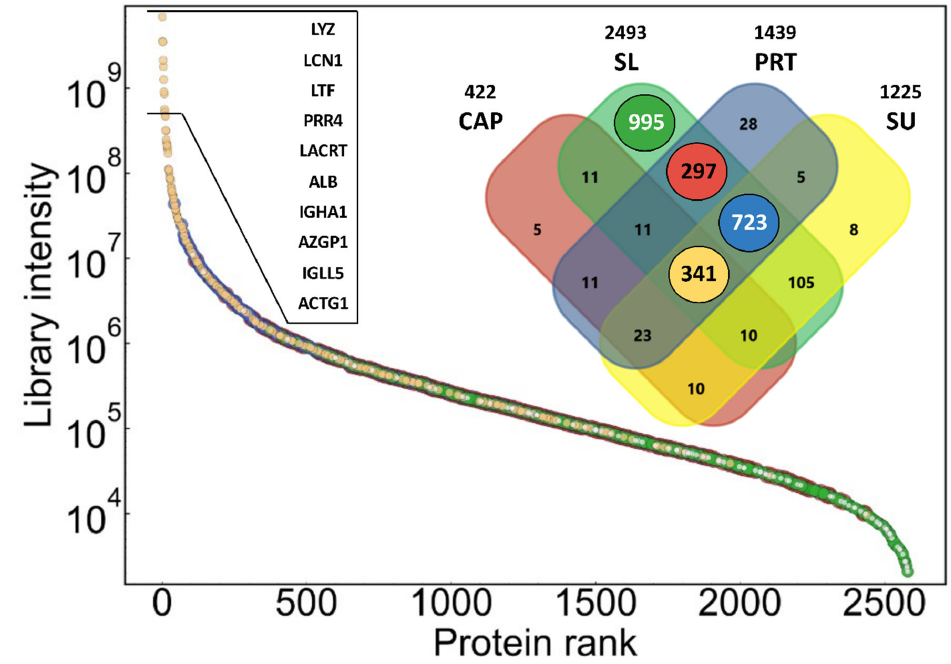
Figure 1. Summed intensity of proteins in combined spectral library as a function of protein intensity rank, demonstrating the dynamic range of identified proteins. Data points are colored according to highlighted subsets of the library as shown in the Venn diagram insert, to demonstrate contribution of different sample types to the library. Gene names of the top proteins are shown in the order of intensity